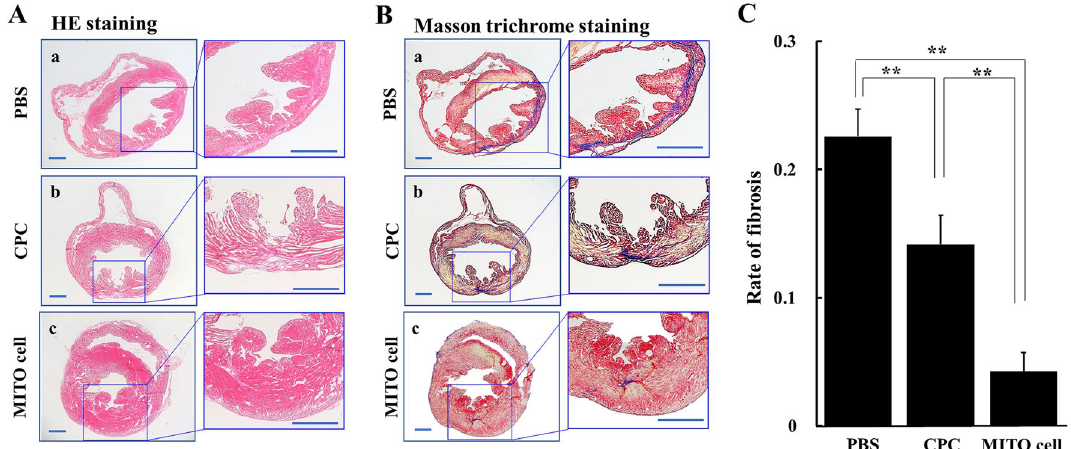
Figure 6. HE and Masson trichrome straining in ischemic myocardium after cell transplantation. HE staining ( A ) and Masson trichrome staining ( B ) in sections of ischemic myocardium 30 days after treatment in each group (PBS group ( a ), CPC group ( b ), MITO-cell group ( c )). Left panels are magnified images of interest of region. Scale bar is 200 μm. ( C ) The photographic images shown in ( B ) were analyzed to determine the rate of fibrosis using Image-pro Plus 7.0. PBS, PBS treated; CPC, CPC transplanted; MITO cell, MITO cell transplanted. Data are represented as the mean ± S.D (n = 5). Significant differences (**p < 0.01) were calculated by one-way ANOVA, followed by the SNK